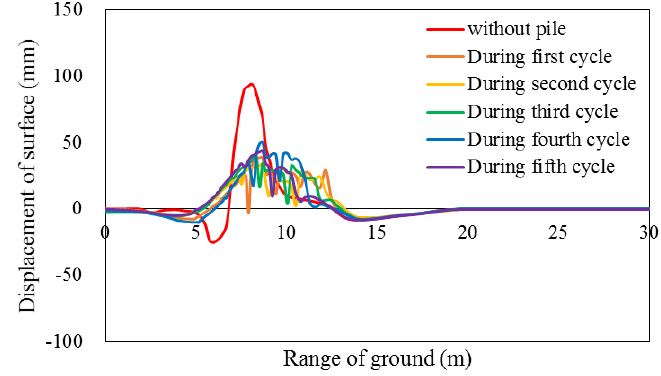
Figure 23. Surface heave trough according to progress of construction at cover depth of 1.5 m.